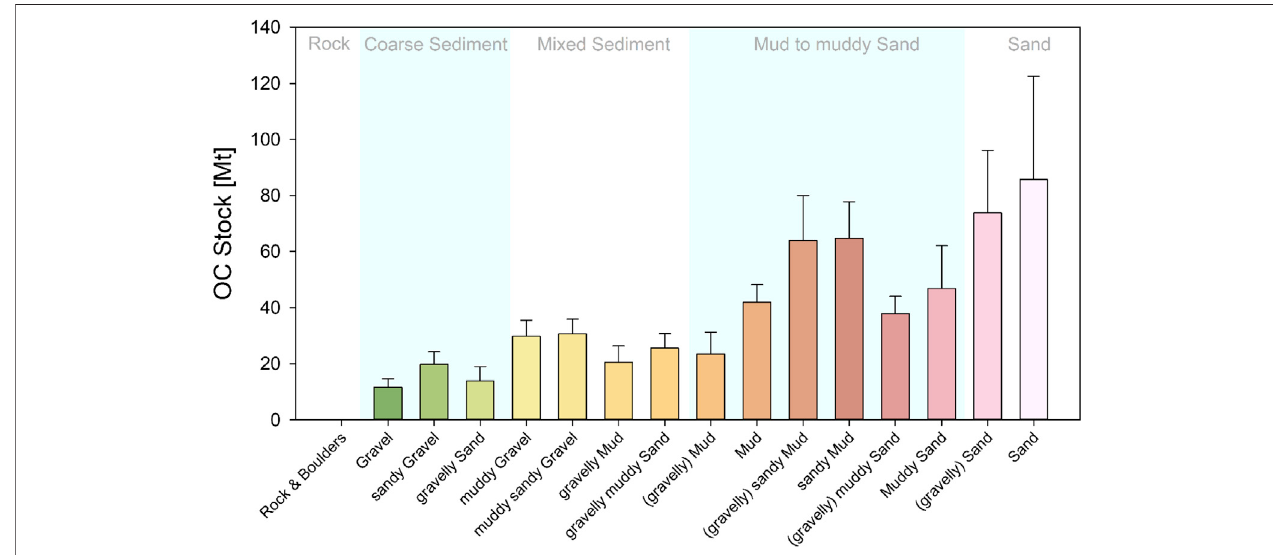
FIGURE 7 | OC stocks [Mt] of the 16 different sediments types across the UK EEZ calculated through the sediment classi fi cation methodology ( Sediment Class Derived OC Stock Section).